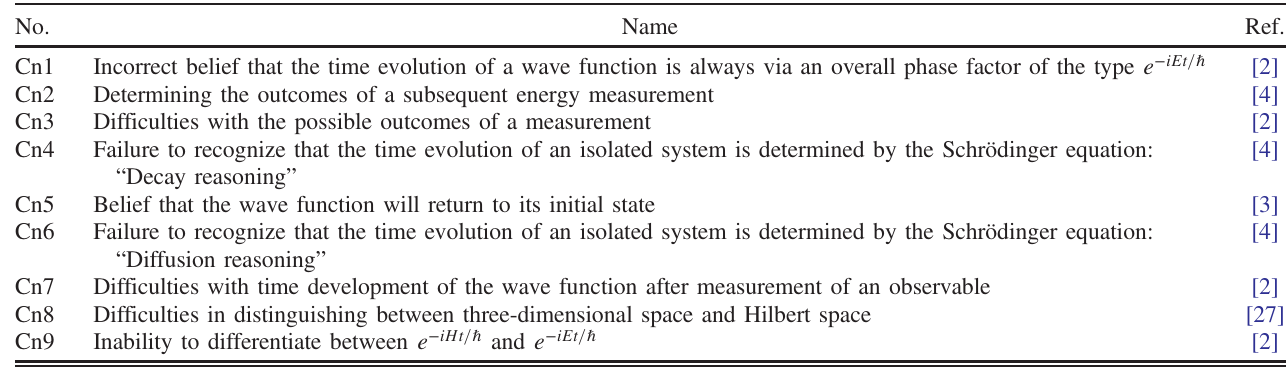
TABLE V. Difficulties that exhibit content error in simpler problems. These difficulties are labeled C for content errors; and n because their problems require no shifting. The ordering of the difficulties in the table is for labeling purposes only and does not represent a